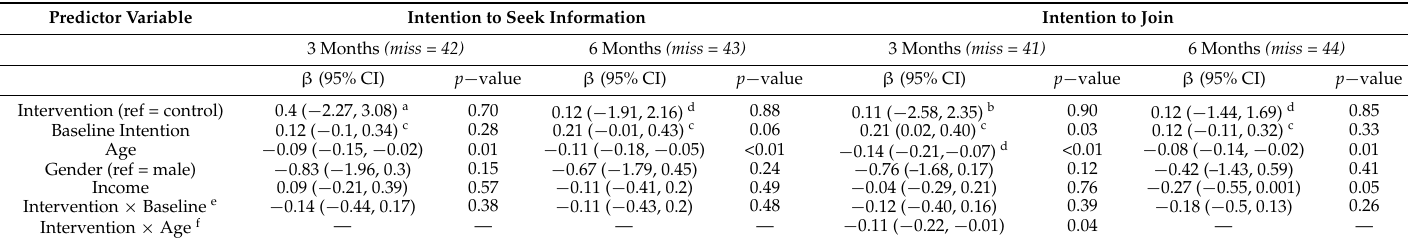
Table 3. Intervention effect estimates and results from multivariable linear mixed models.